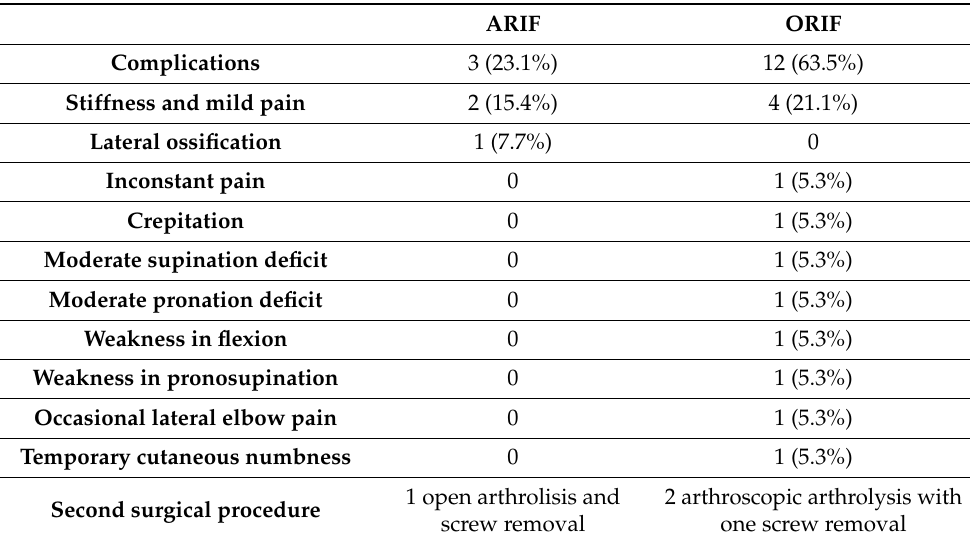
Table 4. Post operative complications and